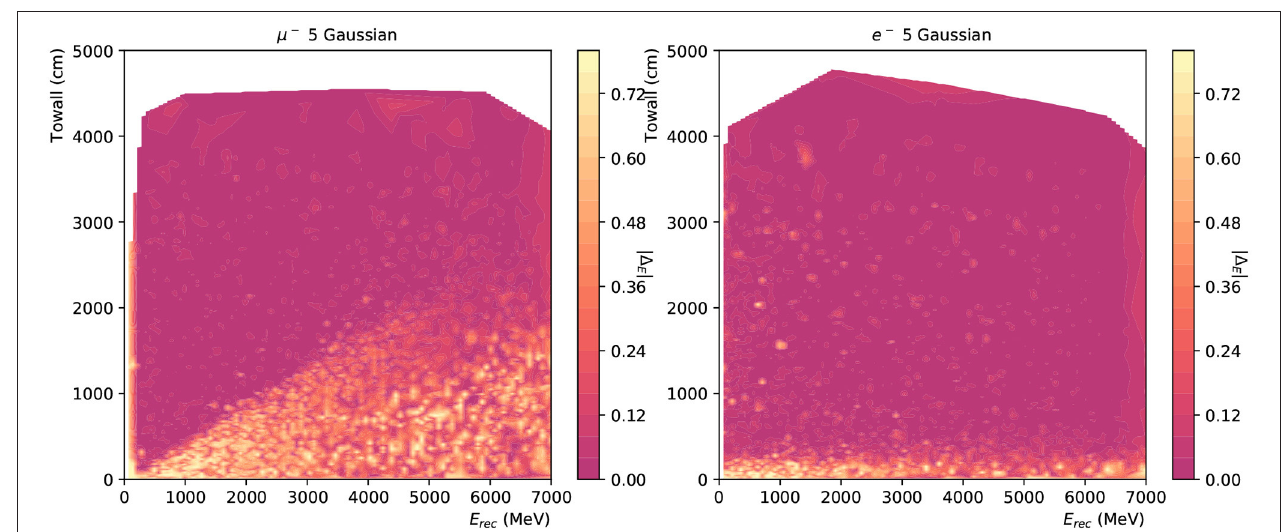
FIGURE 15 | The energy reconstruction performance of 12,000 muon (left) and electron (right) events plotted against the E rec and towall for charge-only network with 5 Gaussian. The saturation level at 0.8 is from the energy range for likelihood scans.